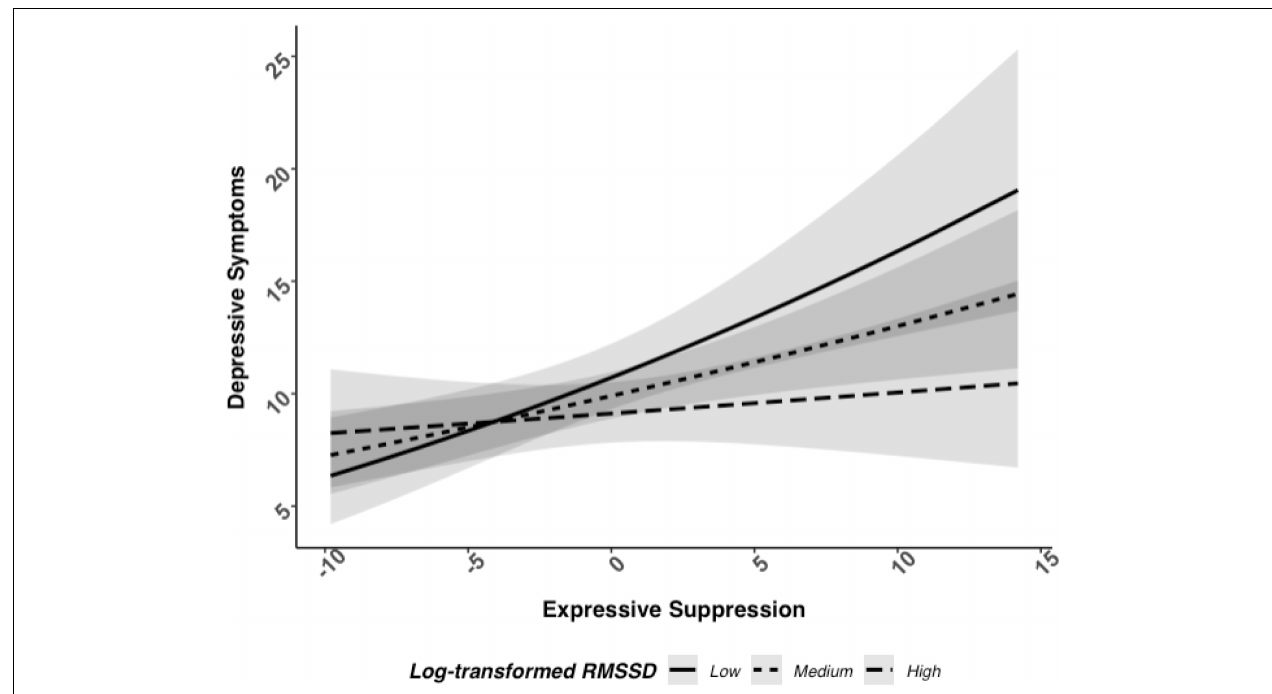
FIGURE 1 | Relationship between log RMSSD, expressive suppression, and depressive symptoms when adjusted with